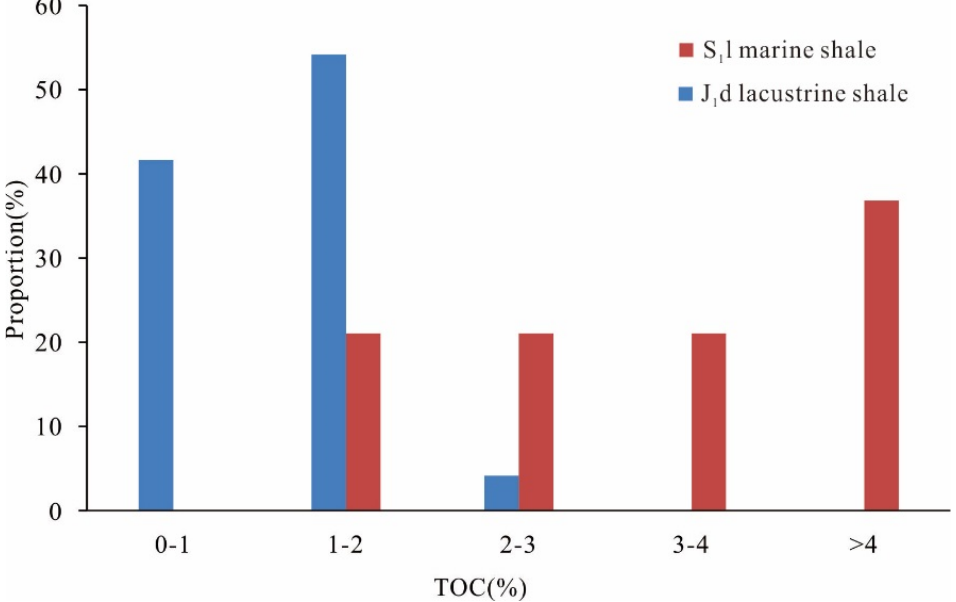
Figure 2. Histogram showing the measured TOC of the Silurian Longmaxi marine-shale samples and the Lower Jurassic Dongyuemiao lacustrine-shale samples.